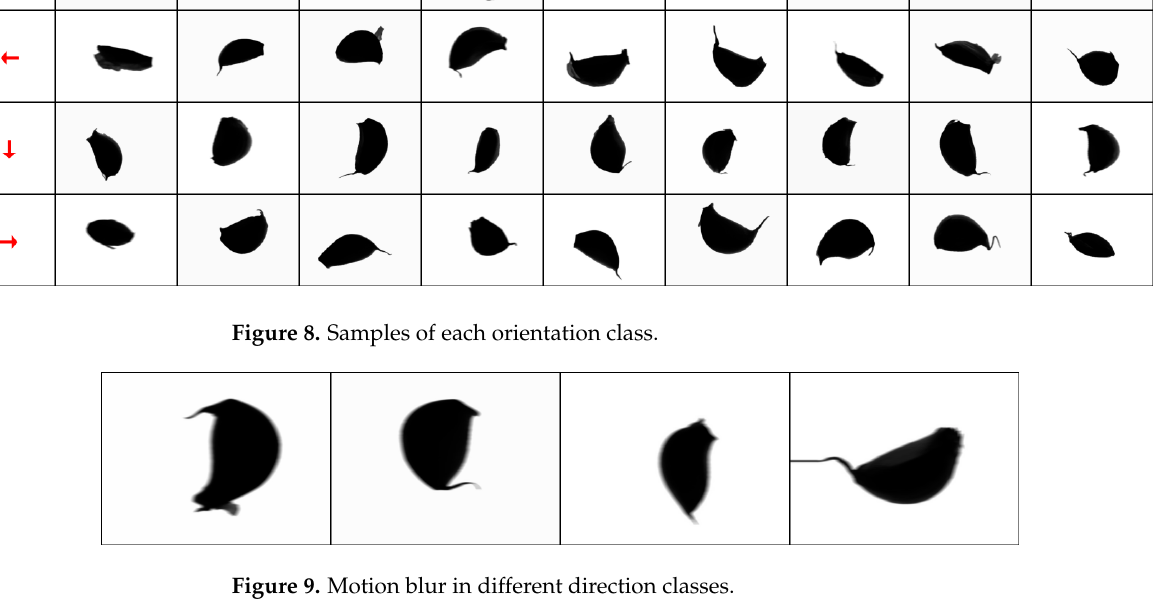
Figure 9. Motion blur in different direction classes.